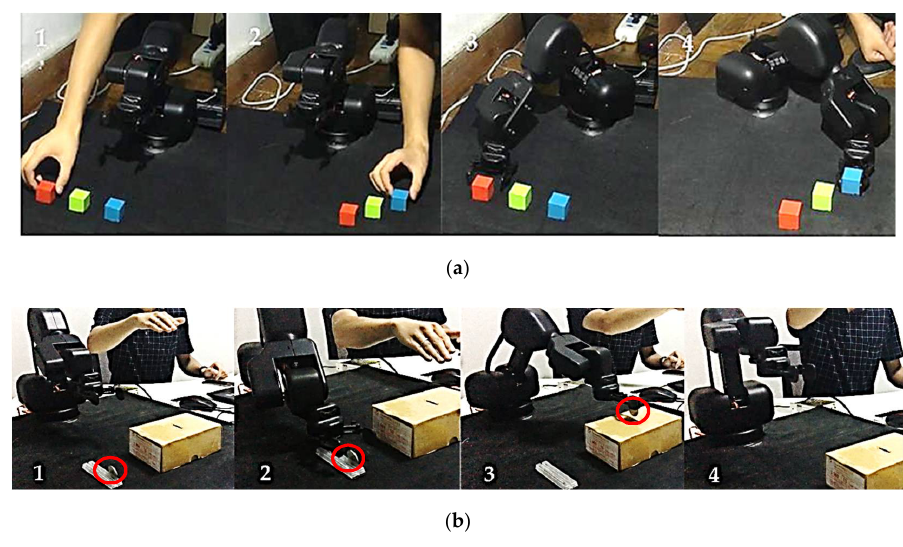
Figure 10. Two experiments on workpiece placement and coin manipulation. ( a ) Experiment on workpiece placement. ( b ) Experiment on coin manipulation.